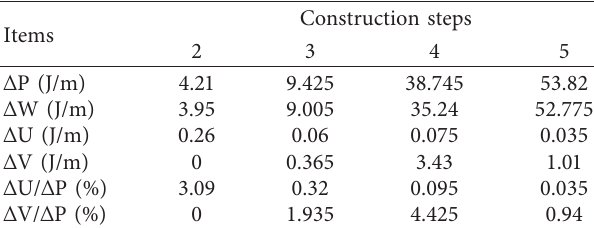
Table 3: The energy increment of each step. Items